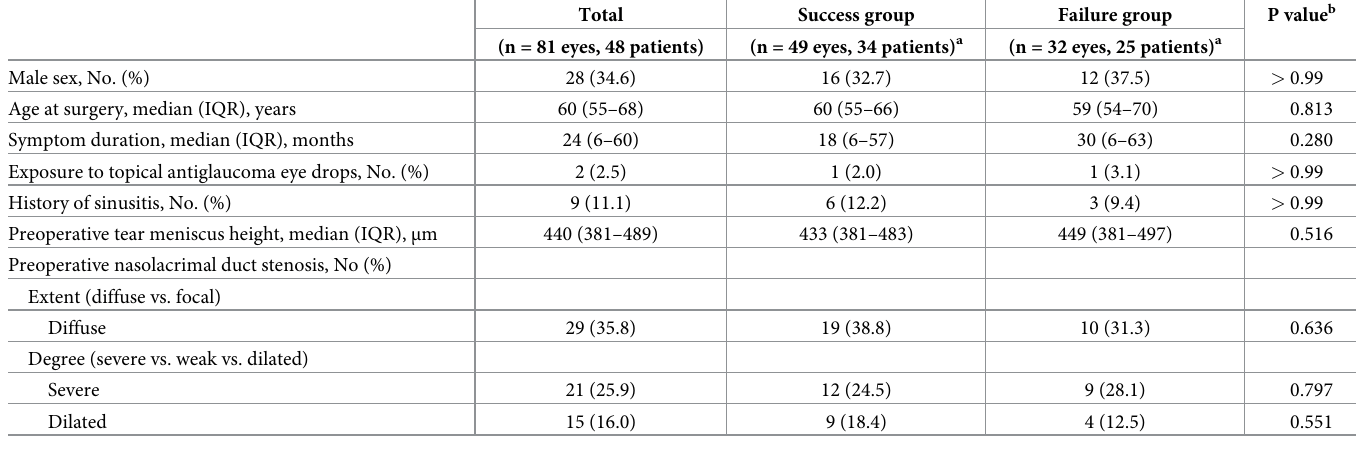
Table 1. Demographics and clinical characteristics of the success and failure groups after nasolacrimal silicone intubation. Total Success group Failure group P value b (n = 81 eyes, 48 patients) (n = 49 eyes, 34 patients)